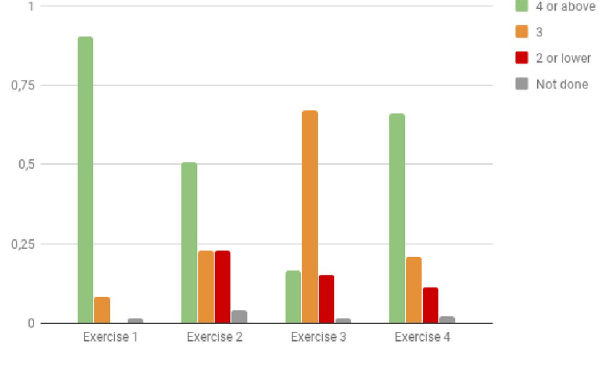
Fig. 10 Results obtained for variant 3—full system, including the robotic exercise buddy. In graphs a, b the blue bars represent the average score obtained for the corresponding item, with the black